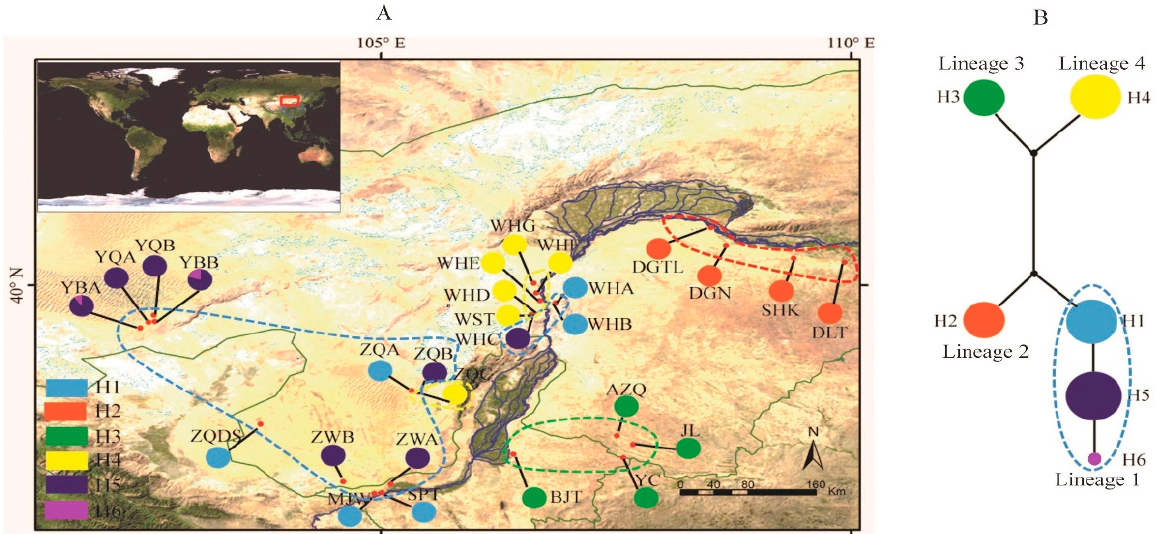
Figure 1. ( A ) Geographic distribution of cpDNA haplotypes (H1–H6) detected in the 28 populations of Stilpnolepis centiflora . The colored dashed curve lines delimitate the population groups (I–IV) resulting from SAMOVA and network analysis. Blue: lineage I; red: lineage II; green: lineage III; yellow: lineage IV. ( B ) The size of circles corresponds to the frequency of each haplotype. The small black circles on the branches represent hypothetical missing haplotypes.